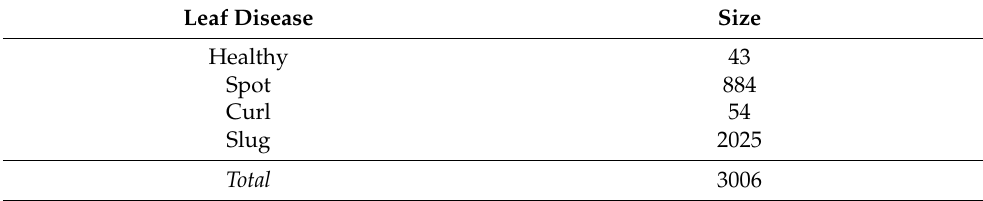
Table 3. Dataset